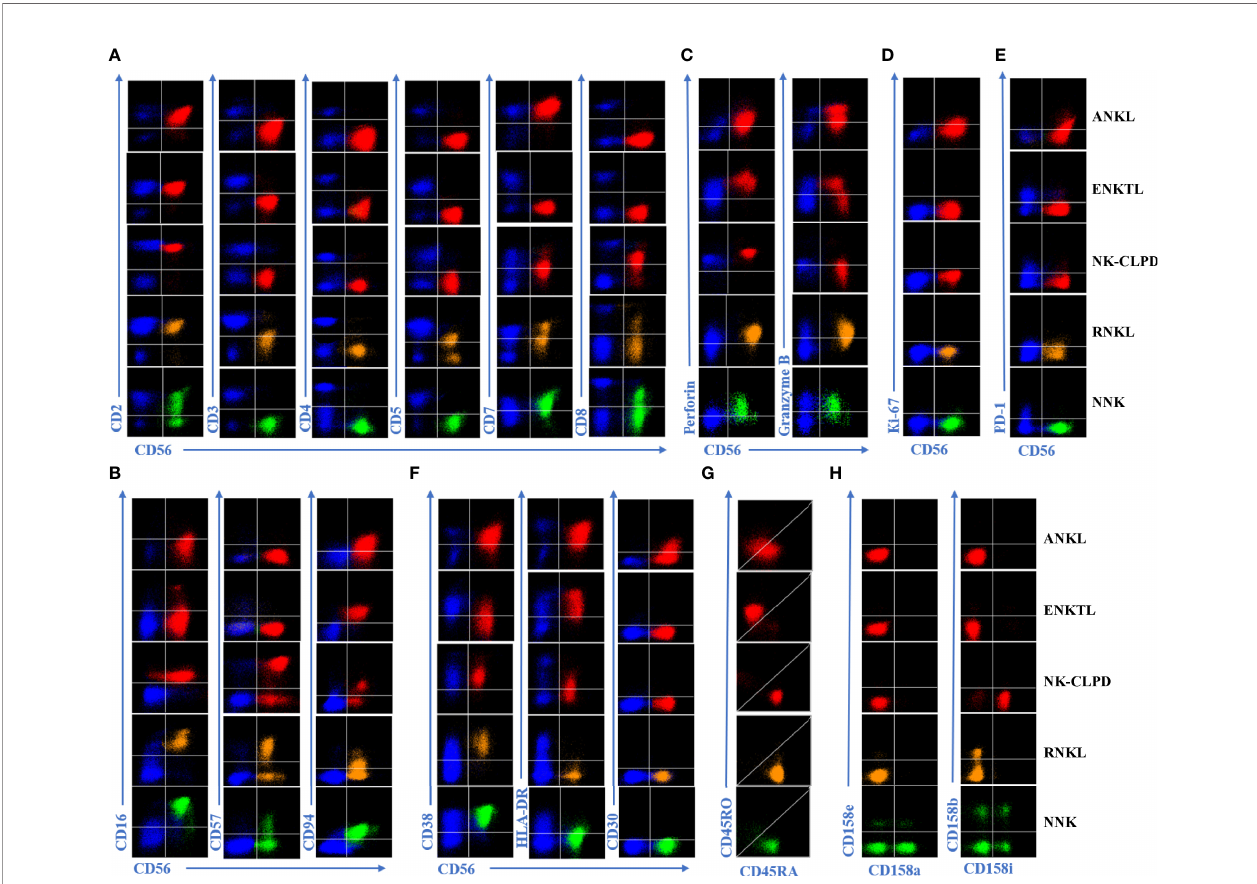
FIGURE 1 | Expression of different extracellular and intracellular markers in ANKL, ENKTL, NK-CLPD, RNKL, and normal NK cells. (A) Cell surface pan-lineage- associated markers were analyzed by fl ow cytometry. Representative FACS plots show the expression of CD2, sCD3, CD4, CD5, CD7, and CD8 in tumorigenic NK cells, reactive NK cells, and normal NK cells. (B) Analysis of lineage-speci fi c markers of NK cells. Representative FACS graphs show the expression of CD16, CD56, CD57, and CD94 in each group of NK cells. (C) Analysis of functional markers of NK cells. Graphs show the expression of Granzyme B as well as Perforin in each group of NK cells. (D) Representative FACS graph showing the expression of Ki-67, a proliferation marker for each group of NK cells. (E) Representative FACS graphs showing the expression of the depletion marker PD-1 in each group of NK cells. (F) Representative FACS graphs showing the expression of activation markers CD30, CD38, and HLA-DR in each group of NK cells. (G) Analysis of the differences between CD45RA and CD45RO in aberrant NK cells. Representative FACS graphs show the expression of abnormal indicator markers CD45RA and CD45RO in each group of NK cells. (H) The Clonality of NK cells was determined by analyzing the expression distribution of KIRs. Representative FACS graphs show the expression of CD158a, CD158b, CD158e, and CD158i in each group of NK cells. Red scatter dots represent tumorigenic NK cells, yellow scatter dots represent reactive NK cells, and green scatter dots represent normal NK cells. The blue scatters on the graph represents other normal T lymphocytes in the background and can be used as a negative or positive control for